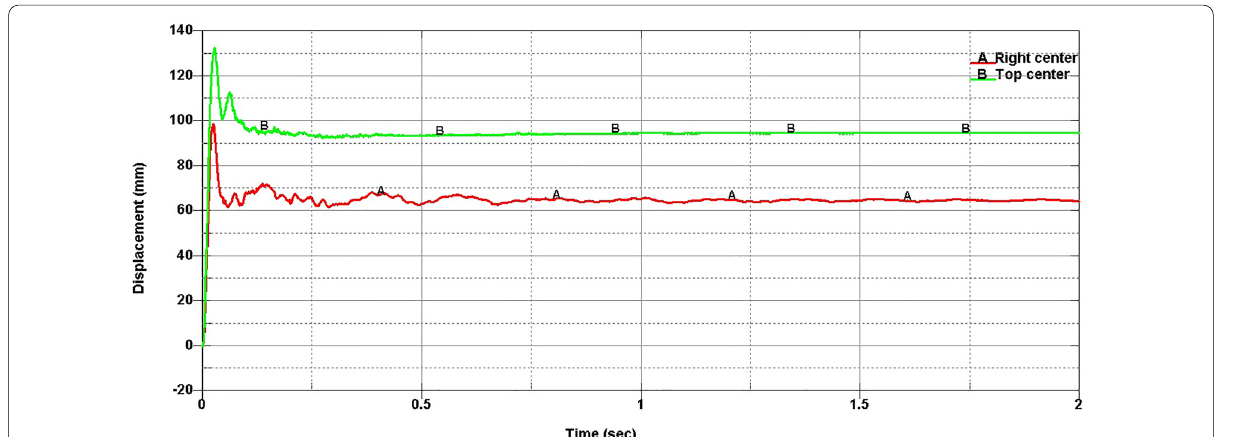
Fig. 8 Displacement measurement data (TNT 2